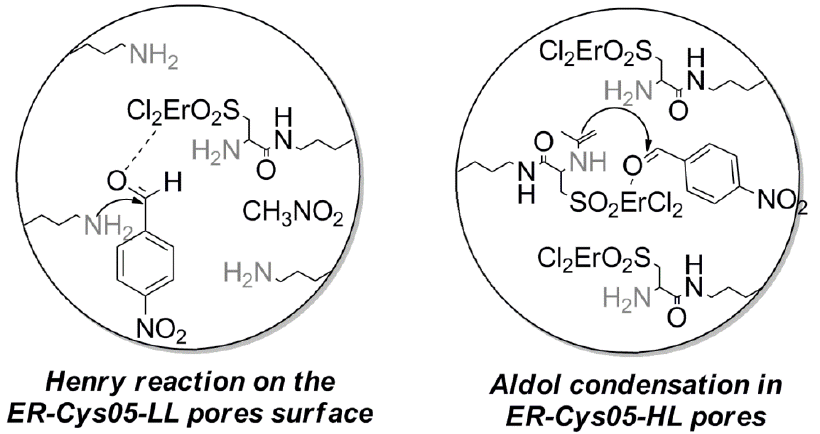
Figure 3. Proposed reaction mechanisms: ( Left ) Henry reaction catalyzed by Er-Cys05; ( Right ) aldol condensation catalyzed by